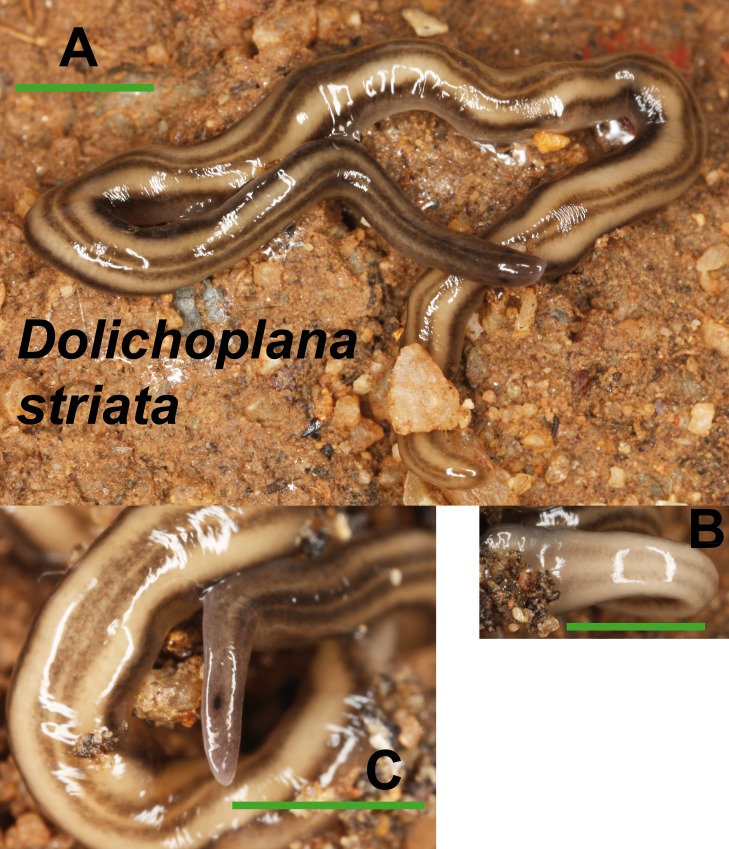
Dolichoplana striata.(A) Dorsal view. (B) Ventral view of median part. (C) Lateral view of anterior end showing the eye spot. Scale bar 5 mm.